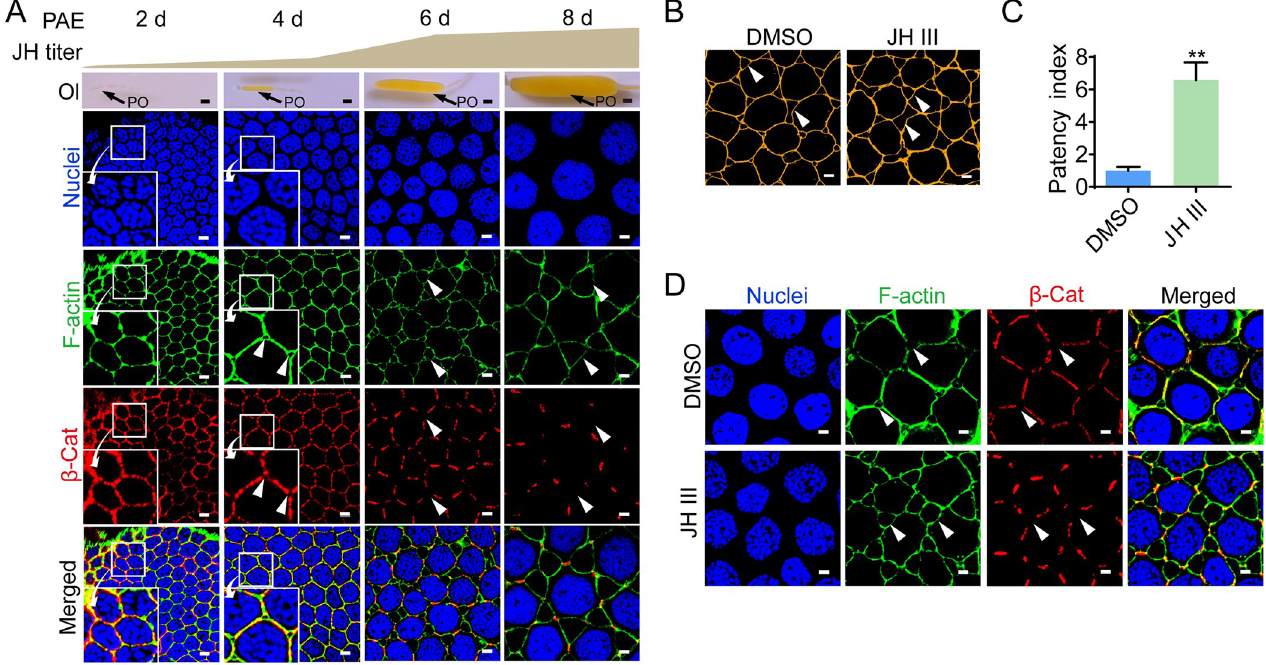
Fig 1. Dynamics of β -Cat distribution along with patency in the follicular epithelium. (A) Subcellular localization of β -Cat in the follicular epithelium of adult females during the first gonadotropic cycle. PAE, post adult eclosion; Arrow heads indicate patency. Large square is the amplification of small square. Ol, ovariole; PO, primary oocyte. Scale bars: ovariole, 0.5 mm; follicular epithelium, 5 μ m. (B) Patency in cultured follicular epithelia of 7-day-old adult females treated by JH at 0.1 μ M for 1 h. Scale bars: 5 μ m. (C) Statistical analysis of patency index in cultured follicular epithelium of 7-day-old adult females. �� , P < 0.01 when compared to the DMSO control. n = 8–10. (D) Subcellular localization of β -Cat in cultured follicle epithelium of 7-day-old adult females under JH treatment. Arrow heads indicate patency. Scale bars: 5 μ